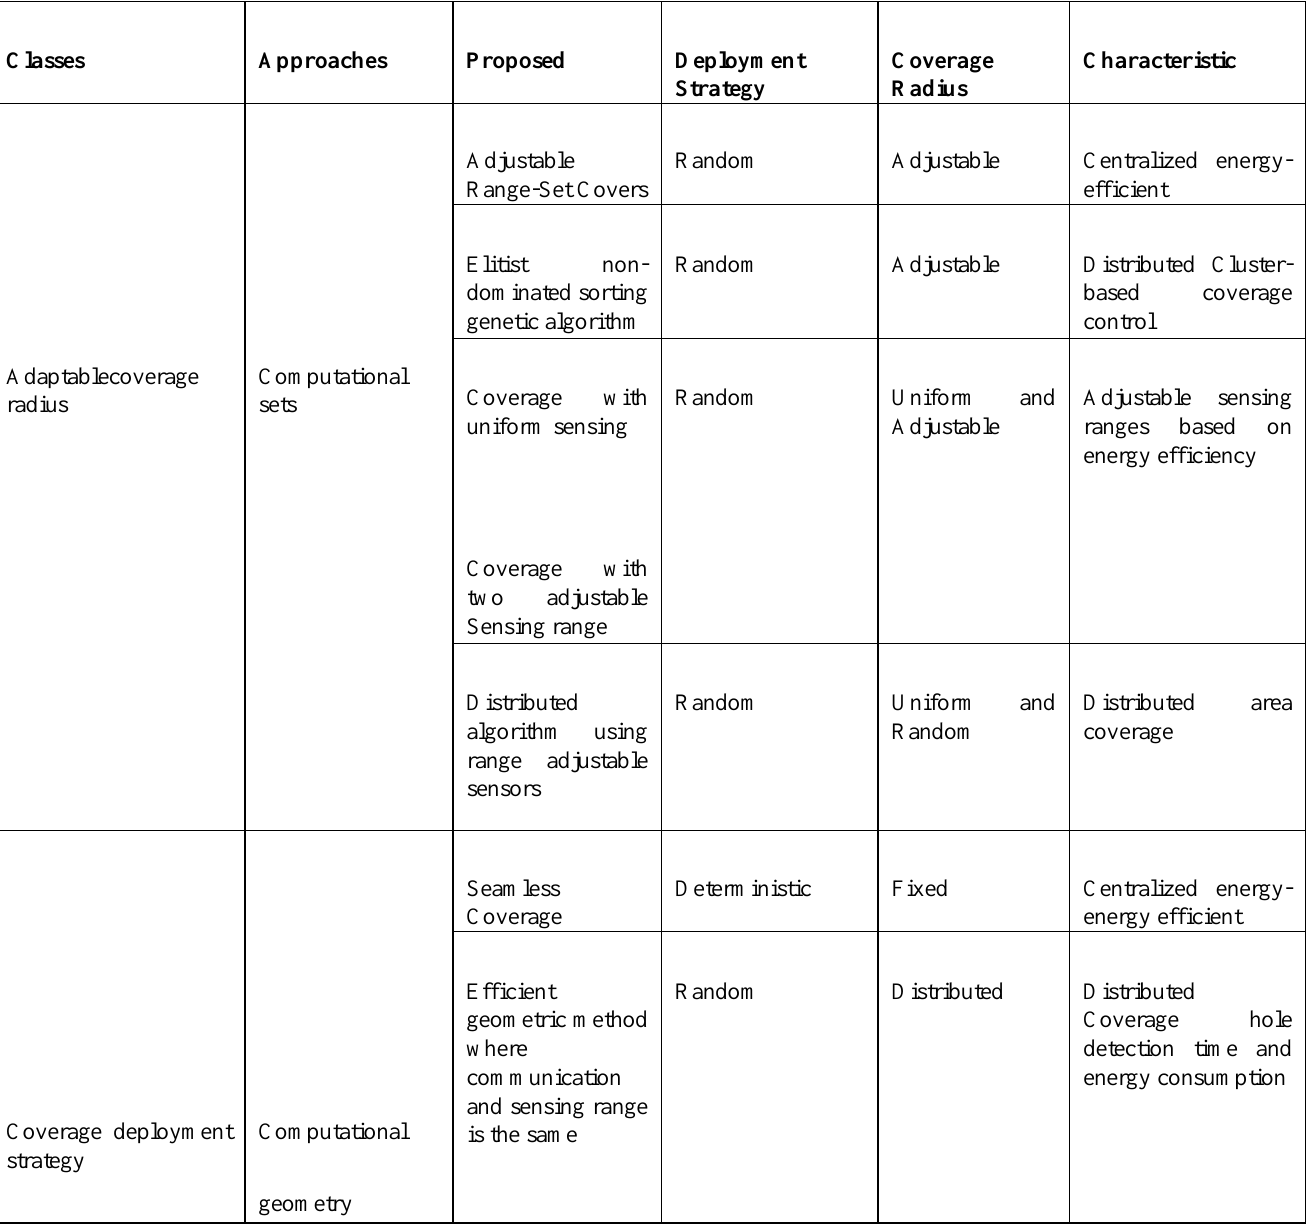
Table 1. Outline the common coverage and network issues in